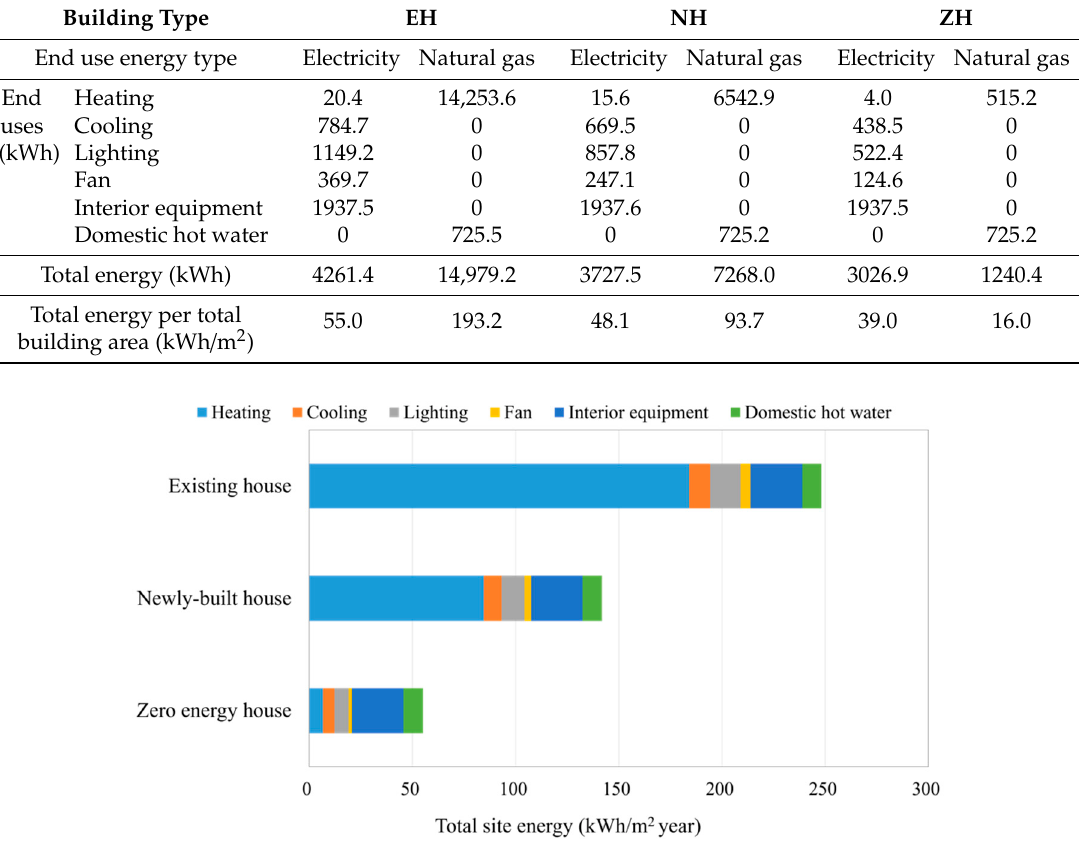
Figure 2. Energy use intensity by building types.